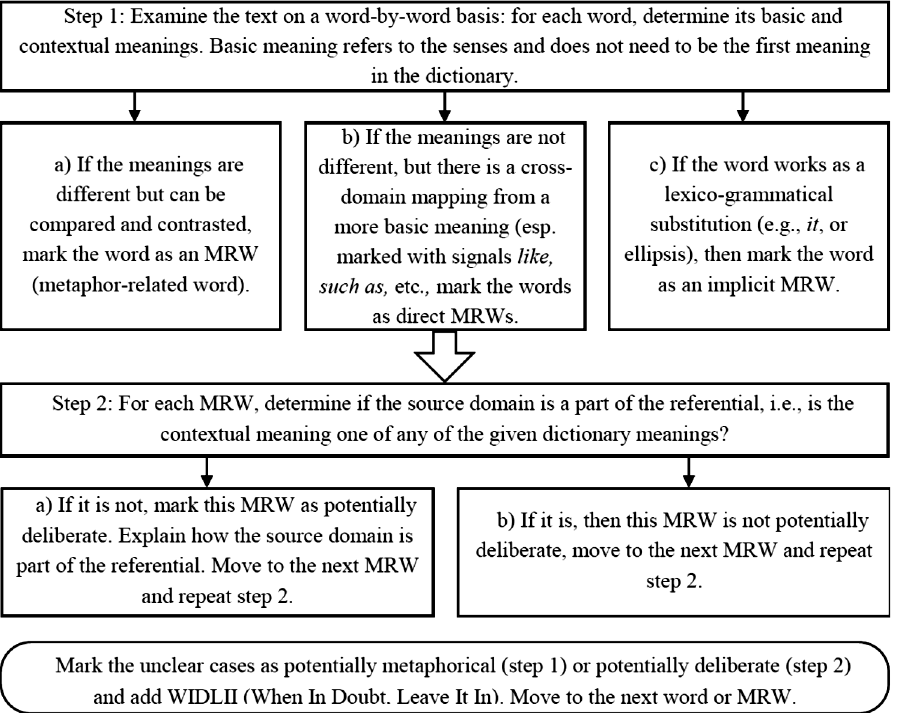
Figure 1. MIPVU and DMIP together (based on Pragglejaz Group, 2007; Steen et al., 2010b; Reijnierse et al.,